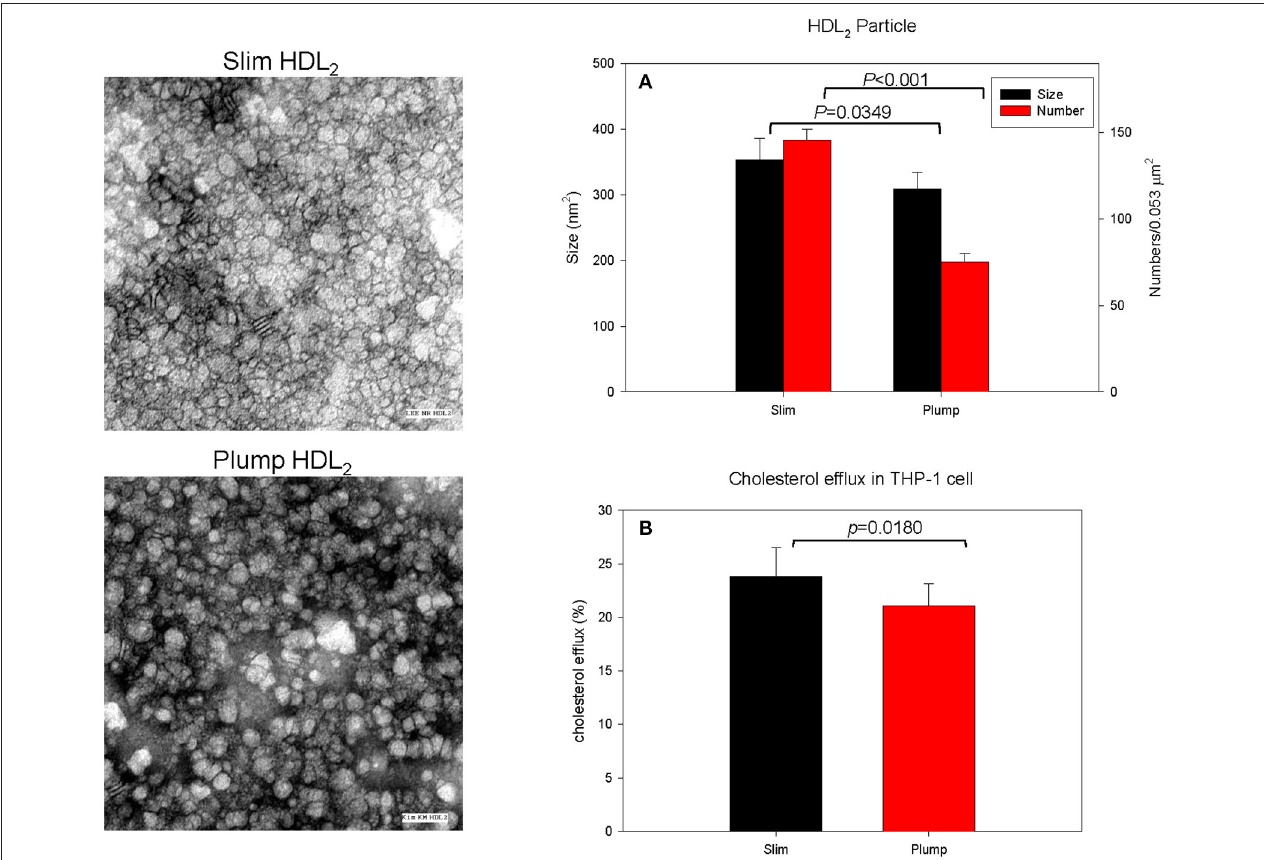
FIGURE 3 | Cholesterol efflux activity and a representative photo of negatively-stained HDL 2 and HDL 3 from slim and plump groups (electron microscopy). All micrographs are shown at a magnification of 40,000 × . The scale bar corresponds to 100nm. (A) Shows measured particle size of HDL and particle number in the designated area. (B) Shows cholesterol efflux activity from macrophages.